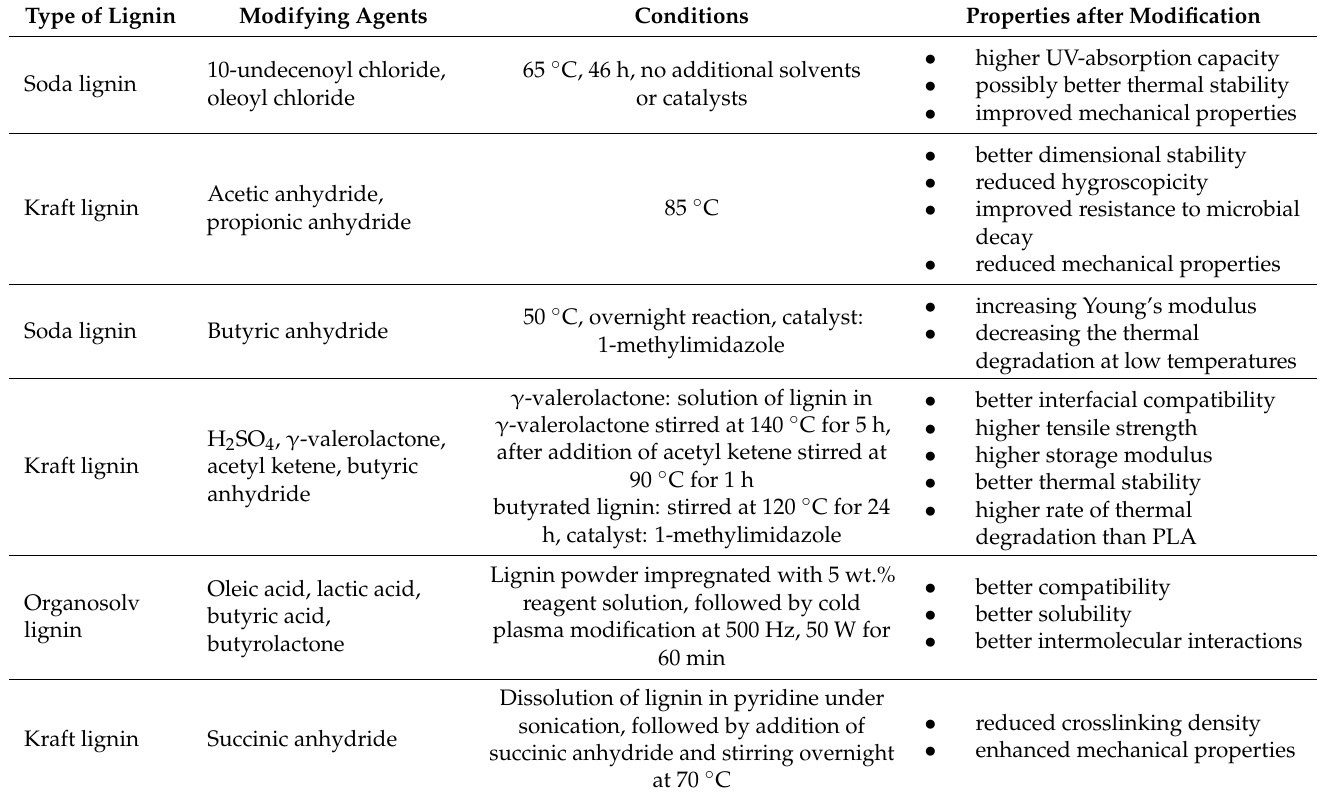
Table 5. Table summarizing the esterification process of